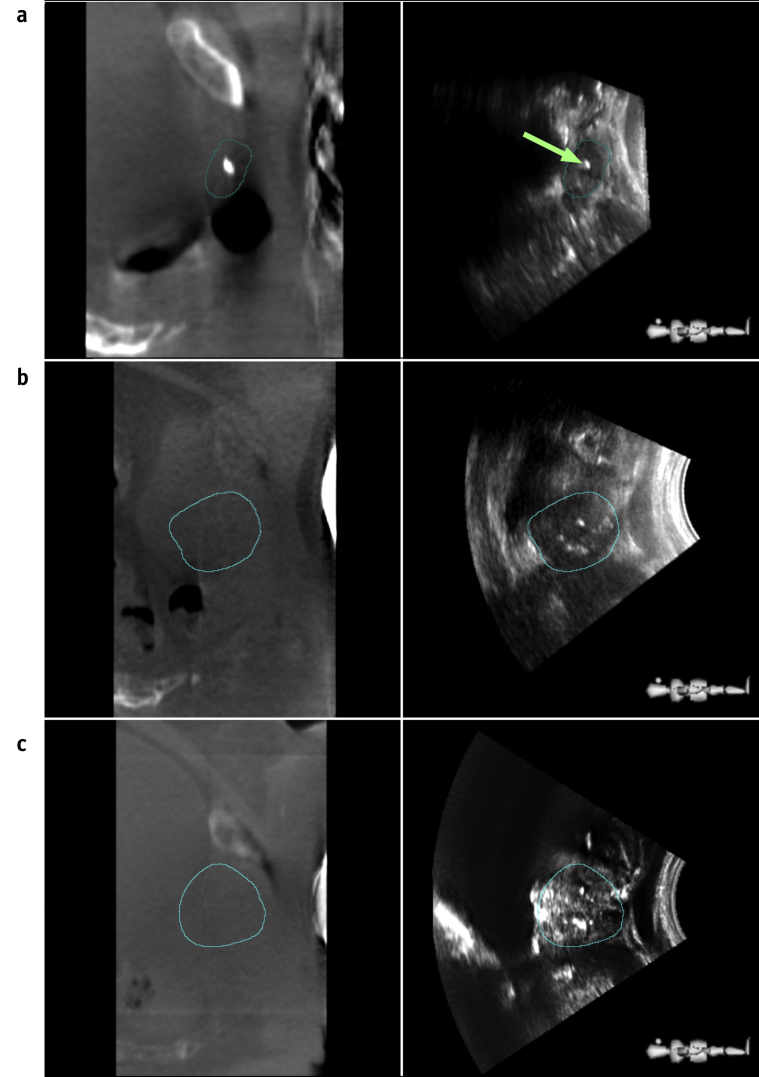
a, Sagittal cone beam computed tomography image with associated transperineal ultrasound image depicting prostate guidance positioning volume contour (blue) and fiducial marker identified visually (green arrow). b, c, Guidance positioning volume features visible on transperineal ultrasound images but not cone beam computed tomography images. High-intensity (white) ultrasound features seen in the central region of the prostate likely are calcifications. Ultrasound features are also observed near the urethra and bladder-prostate interface. (A color version of this figure is available at https://doi.org/10.1016/j.ijrobp.2018.04.008.)